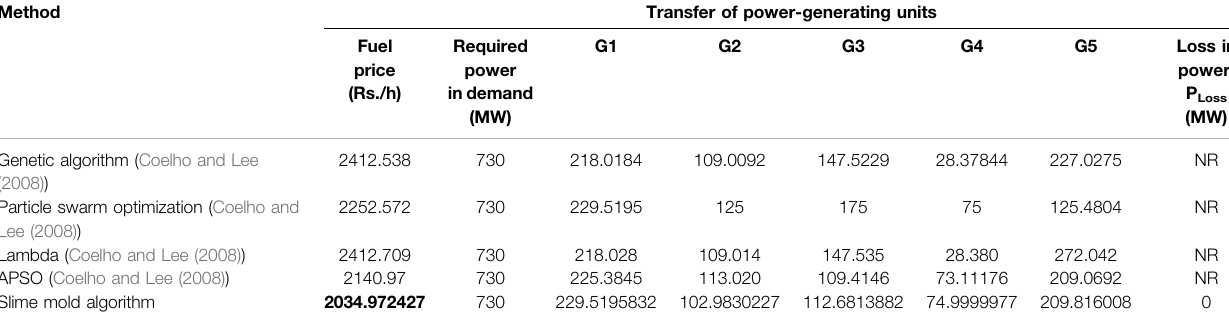
TABLE 2 | Slime mold algorithm results for economic dispatch of 5-unit system (with valve-point effect).